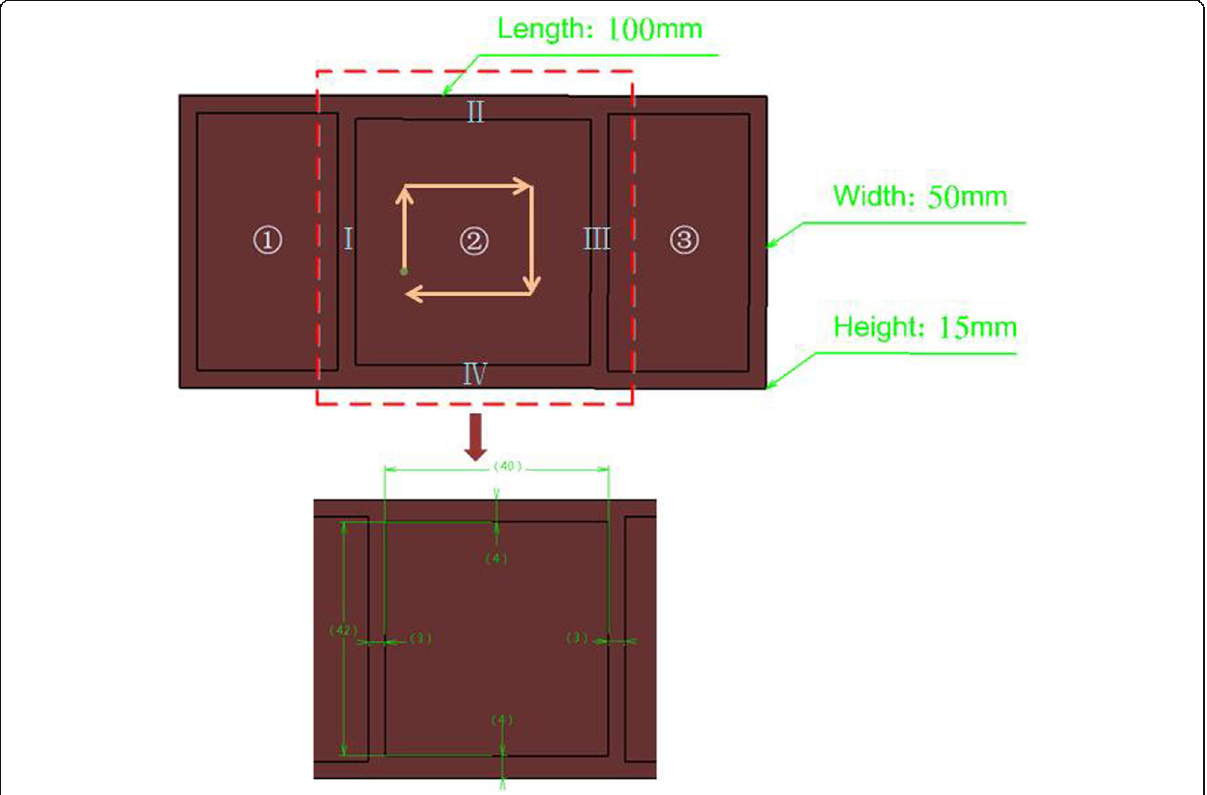
Algorithm of non-uniform allowance allocation method